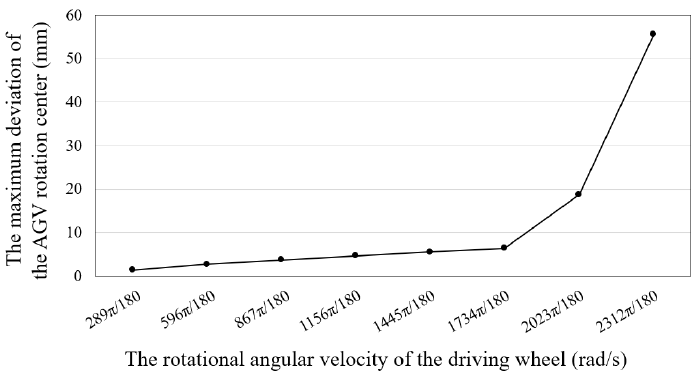
Figure 9. The maximum deviation of rotation center at different angular velocities.